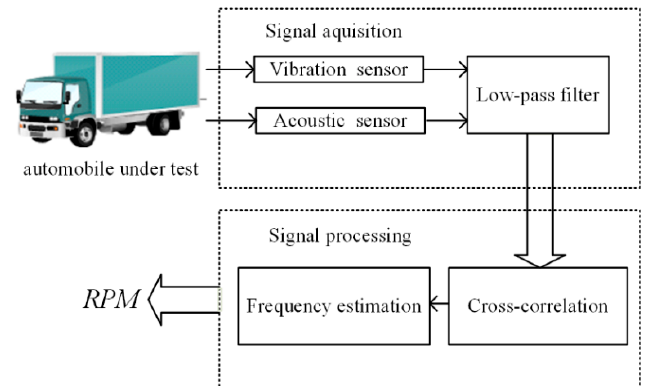
Figure 1. Principle of the measurement system. RPM : revolutions per minute.